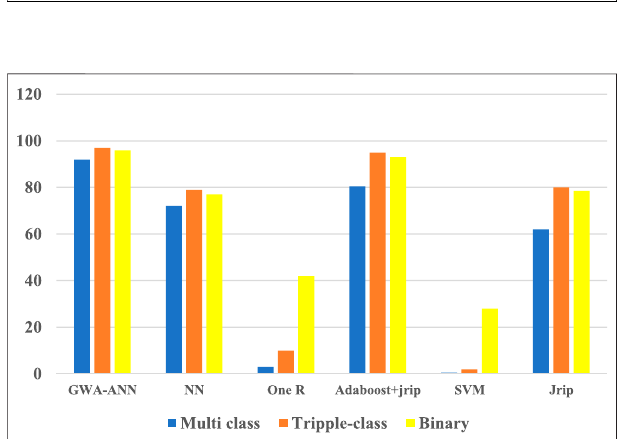
FIGURE 14 | Mean recall amounts of diverse classi fi ers of the 45 datasets.